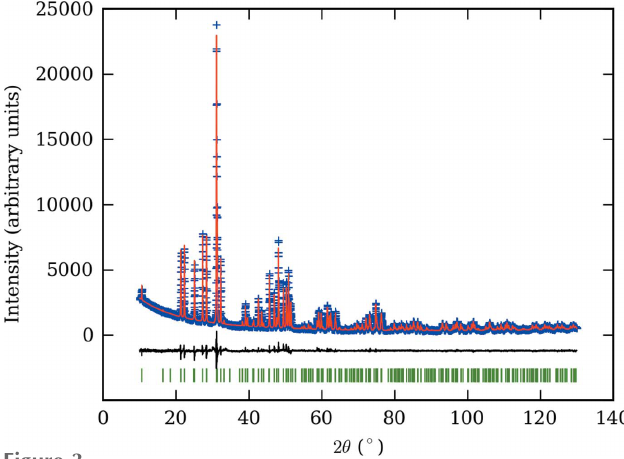
Figure 3 Experimental and calculated X-ray powder data profiles of Ca 2 Ce 8 (- SiO 4 ) 6 O 2 , with difference